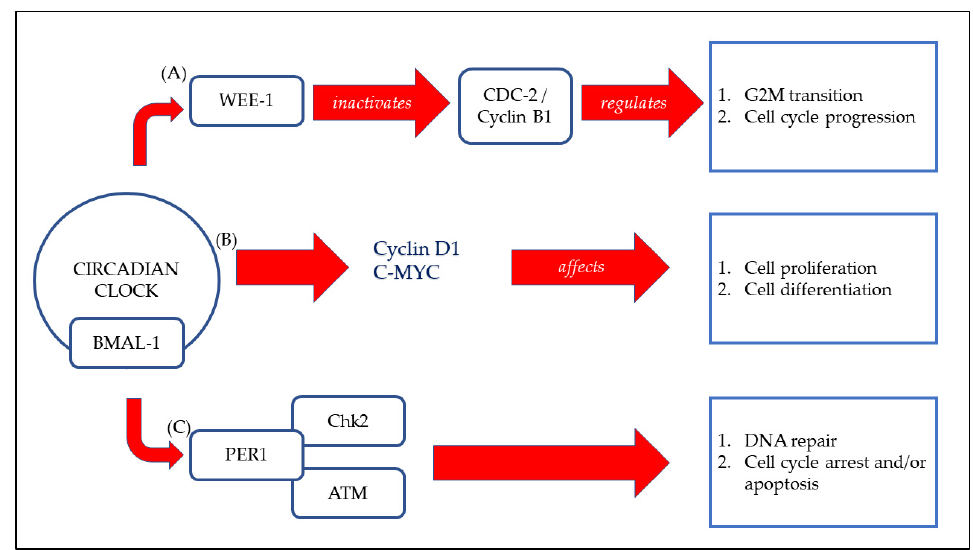
Figure 2. Molecular interaction of cell cycle components with the circadian core clock. ( A ) CLOCK:BMAL1 complex is able to control the transcription of the cell cycle-related gene Wee-1 directly and encodes a protein kinase that inactivates the CDC2/Cyclin B1 complex. Hence, G2-M transition and cell cycle progression are regulated. ( B ) CLOCK:BMAL1 transcriptional activation of the genes encoding Cyclin D1 and C-MYC affects cell proliferation and differentiation. ( C ) PER1 complex with the ATM kinase and the checkpoint kinase Chk2 impinges DNA repair, cell cycle arrest, and/or apoptosis [28].